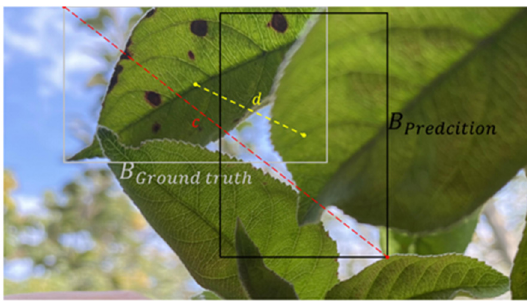
Figure 6. Illustration of CIoU loss for box regression.